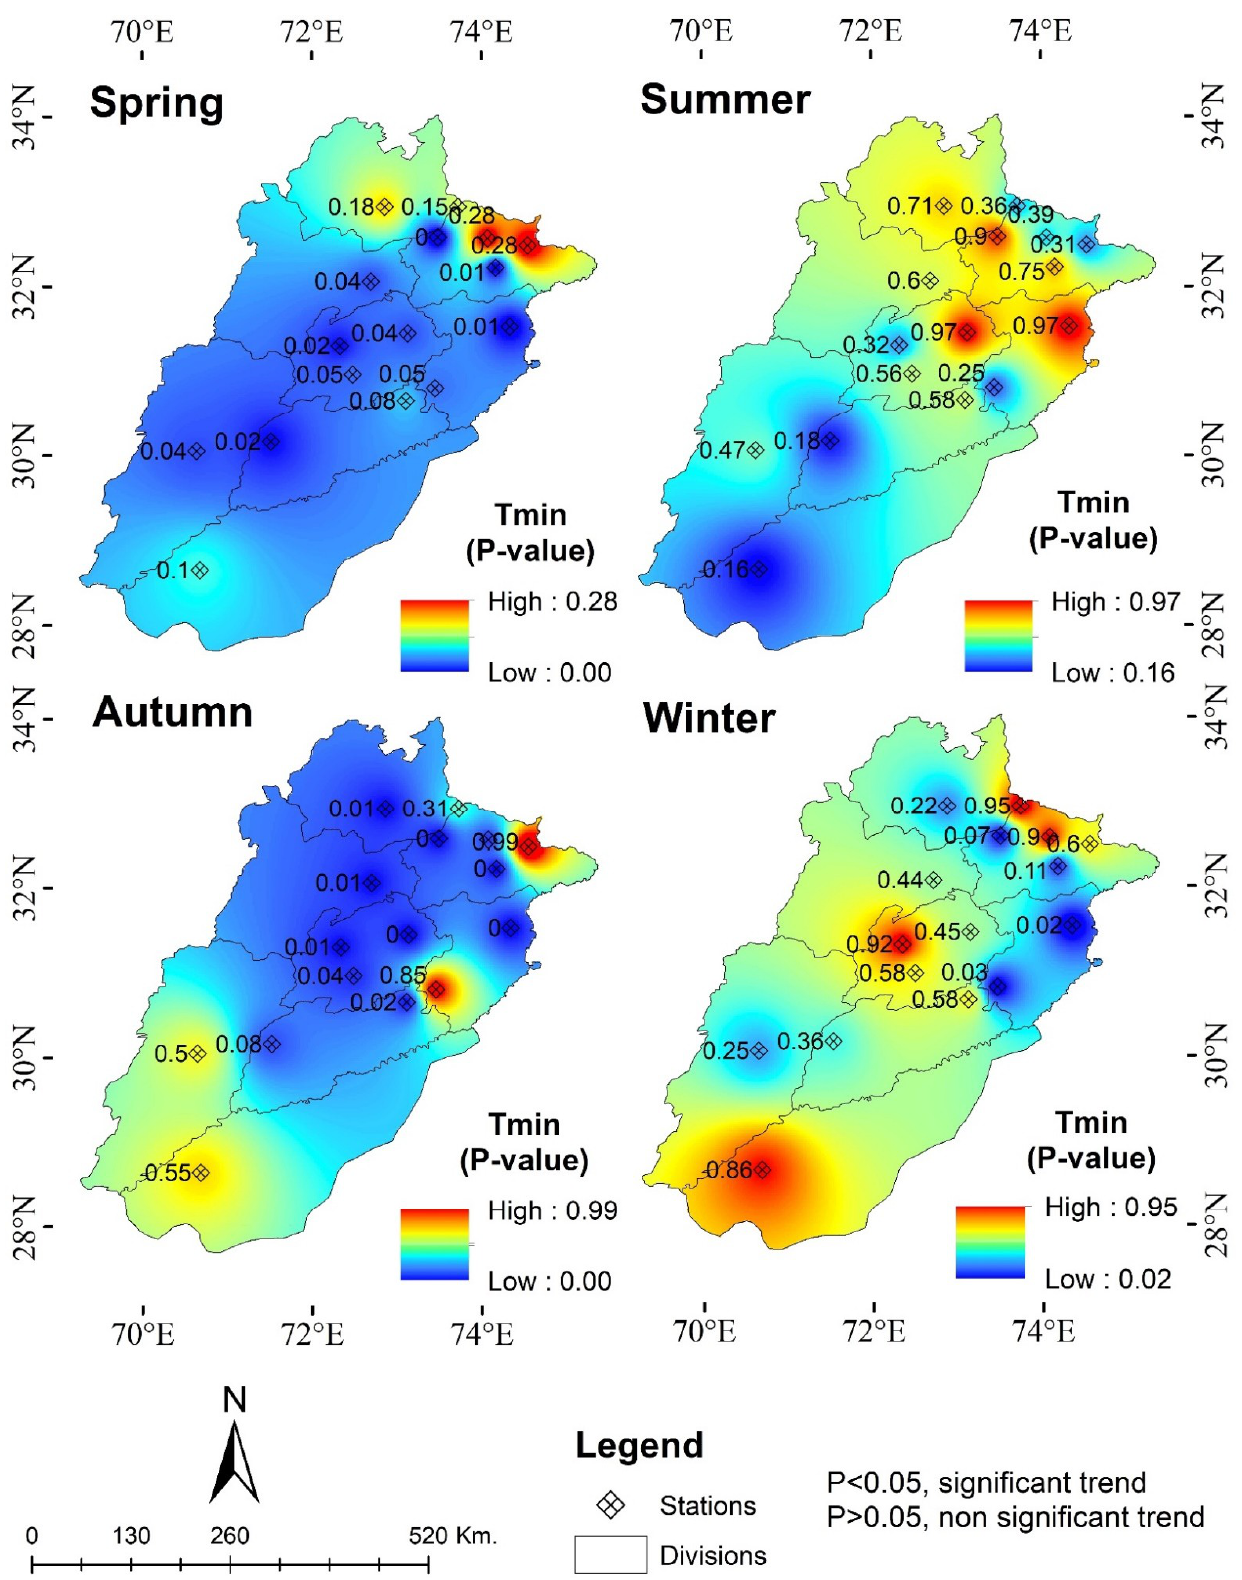
Figure 4. Seasonal p -values and the trends in T min (°C) of the 16 stations of Punjab, Pakistan, over the period 1979–2014.